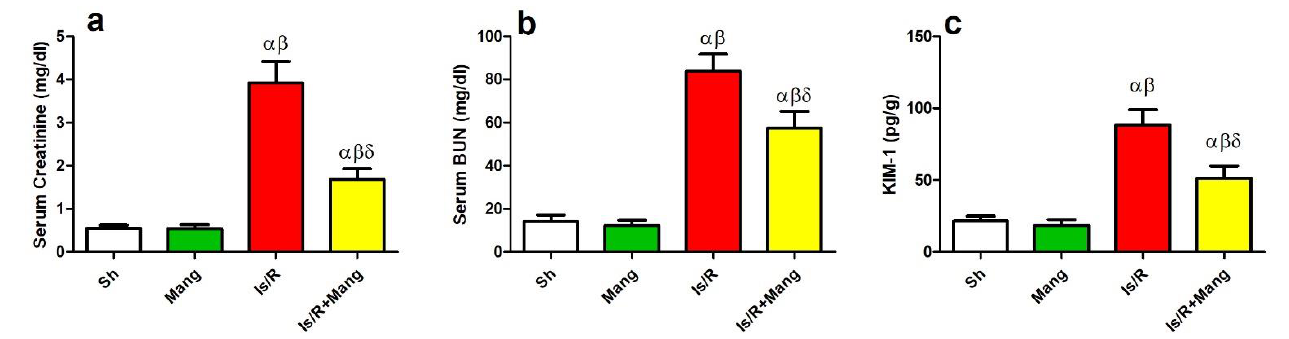
Figure 6. Mang ’s (20 mg/kg, i.p) impact on ( a ) mRNA and ( b ) protein expression of renal Bcl-2, as well as ( c ) mRNA and ( d ) protein expression of renal Bax, and ( e ) IHC of caspase-3 protein. Data were articulated as the mean ( n = 7) ± SD, p value< 0.05 is significant. As compared with sham (α ), Mang ( β), and Is/R (δ) treated groups.